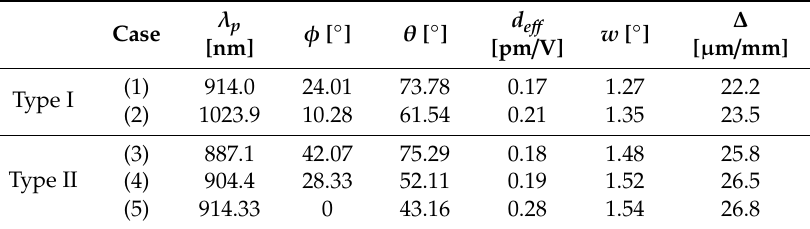
Table 1. Type I and Type II EPM: the resonant pump wavelength ( λ p ), k -directions (i.e., θ and φ ), the e ff ective nonlinear optic coe ffi cient ( d e ff ), the walk-o ff angle ( w ), and the beam deviation ( ∆ ).